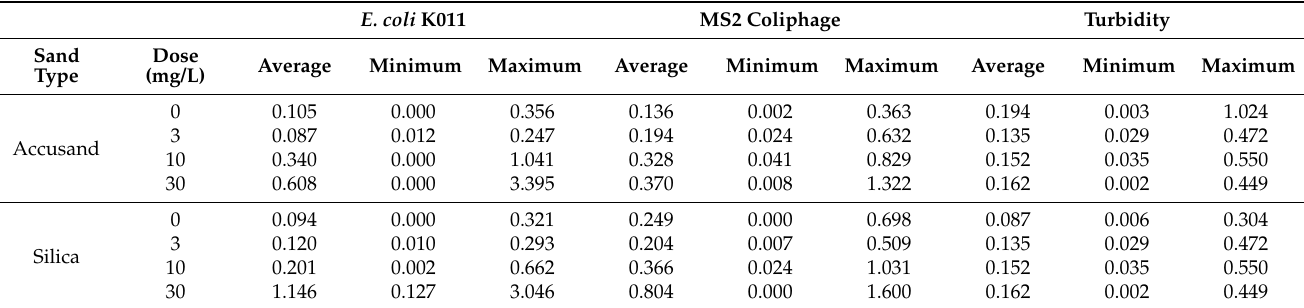
Table 1. Average, minimum and maximum differences in log 10 reduction values between duplicate filters for each sand type and chitosan dose over the 57-day filter operating time. E. coli K011 MS2 Coliphage